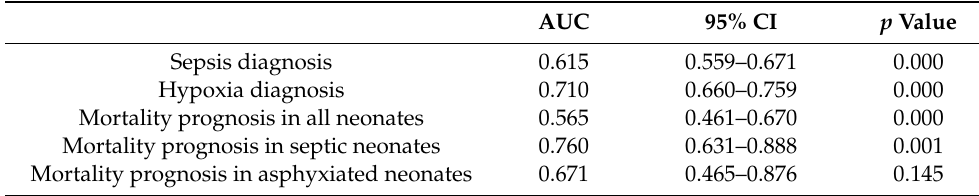
Table 5. Receiver Operating Characteristics curve analysis for NRBCs in study population.